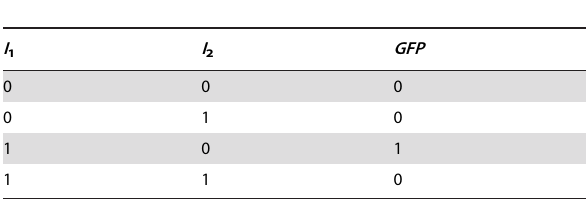
Table 2. Truth table for a NI 2 Boolean